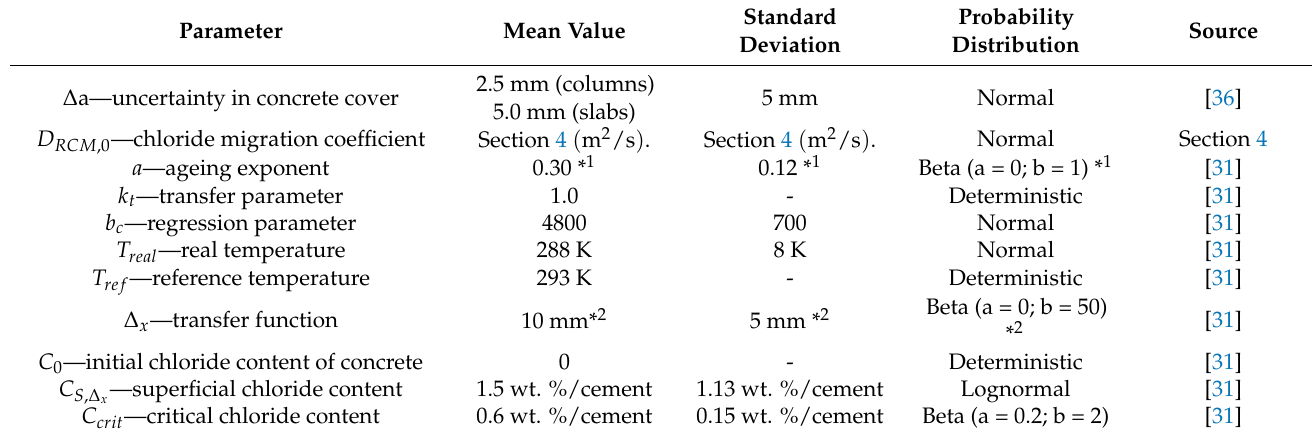
Table 1. Ratio of the standard deviations of recycled aggregate concrete (RAC) and natural aggregate concrete mixes.